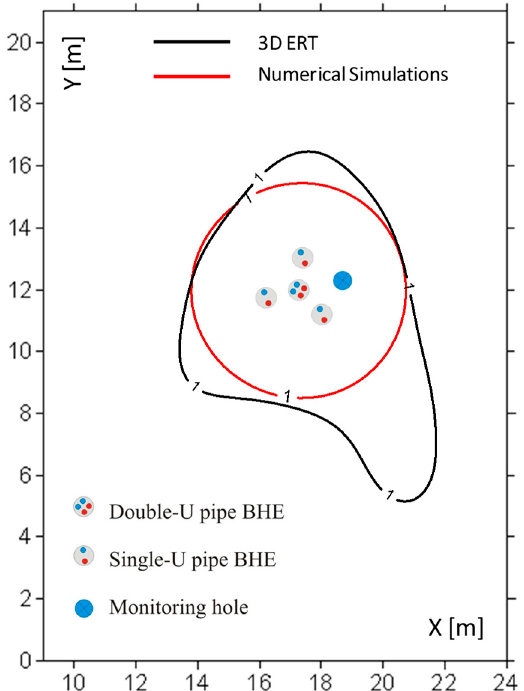
Figure 6. Comparison of the two thermally affected zone (TAZ) (increase of 1 °C temperature from the surrounding) obtained from ERT data interpretation and numerical simulations.